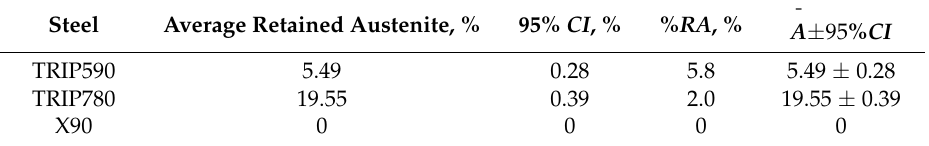
Table 10. The measured retained austenite content in three steels by XRD.